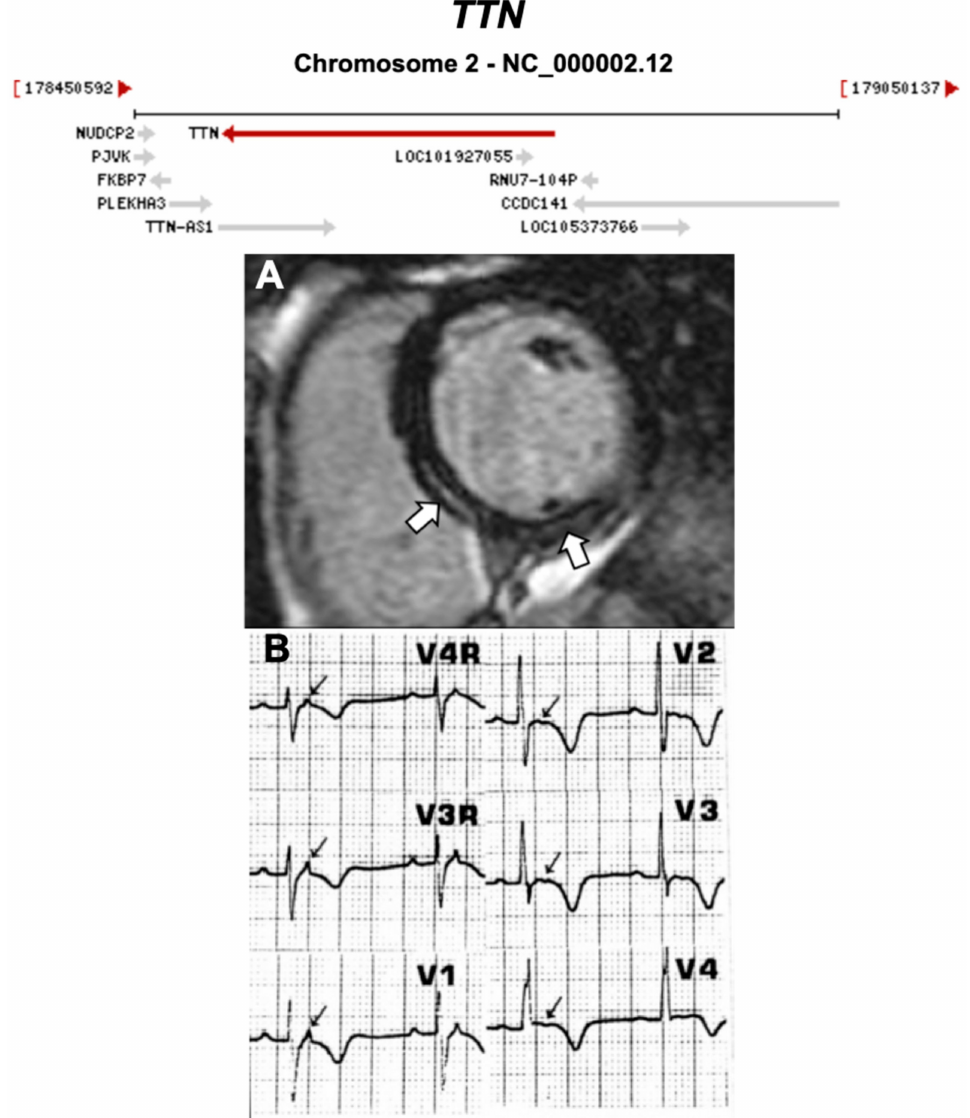
Figure 9. Exemplar MRI and ECG finding found in ACM patients with TTN mutations. ( A ) CMR of a patient with TTN mutation, the white arrows show mid-wall scars in the inferior septum and inferior wall; ( B ) ECG of a di ff erent patient with TTN Thr2896Ile mutation showing epsilon waves. ( A ) was reproduced from Augusto et al. (2019) [39]; ( B ) from Taylor et al. (2011) [40] with